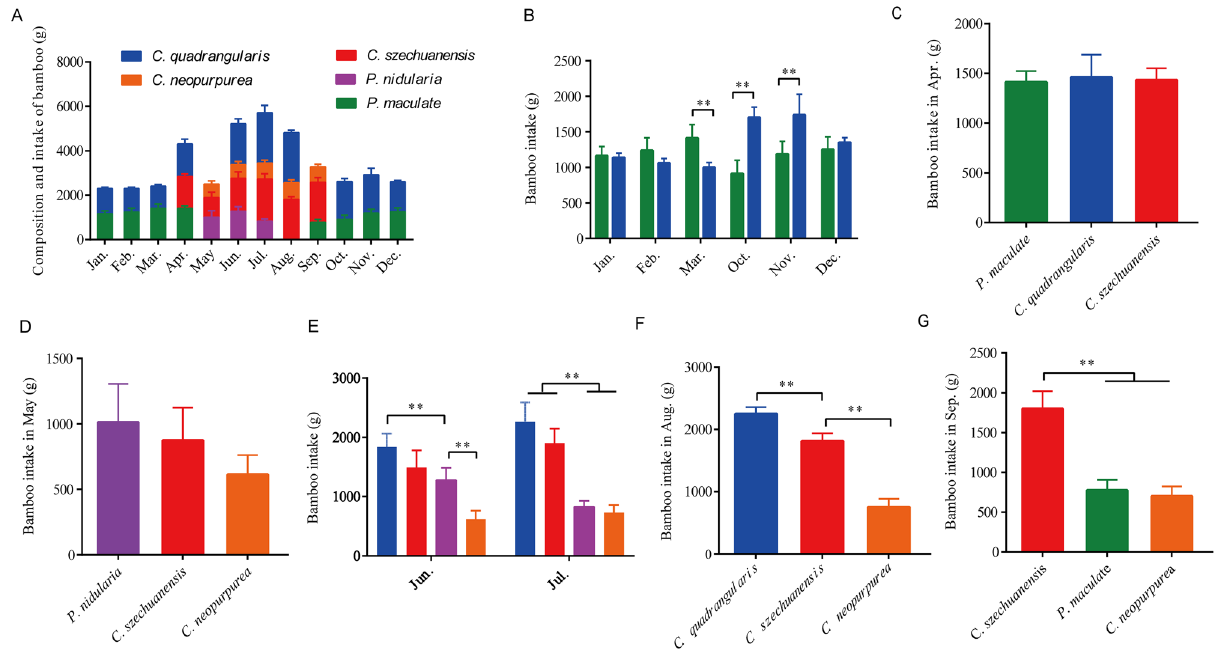
Figure 1. Composition and feed intake of staple food bamboo for captive giant pandas in seasonal